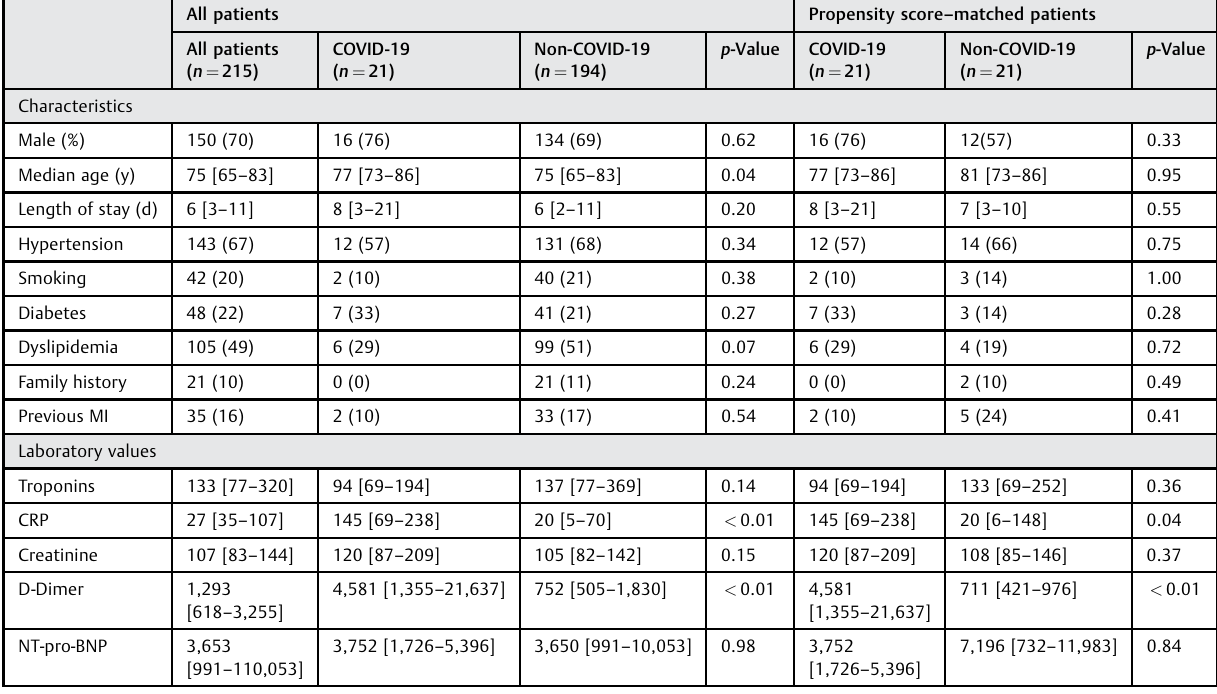
Table 1 Baseline characteristics All patients Propensity score – matched patients